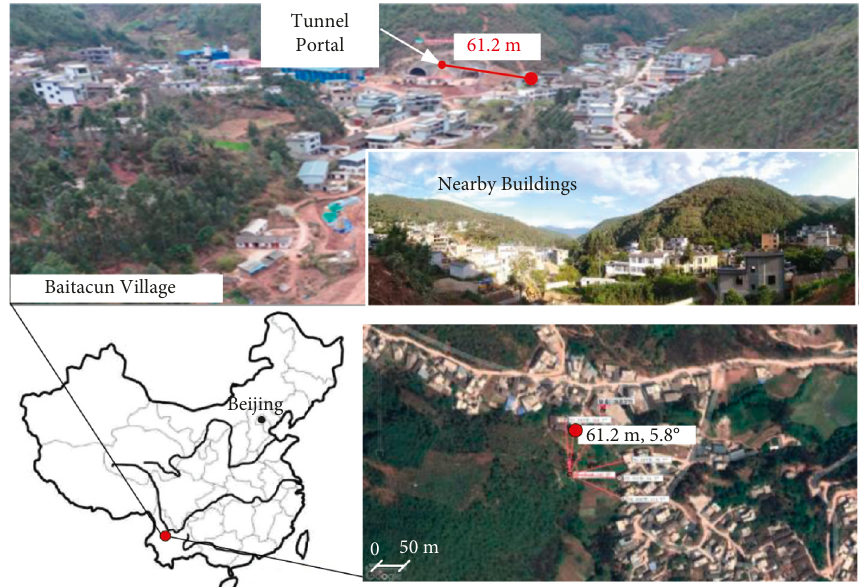
Figure 2: Overview of the area near the tunnel portal.